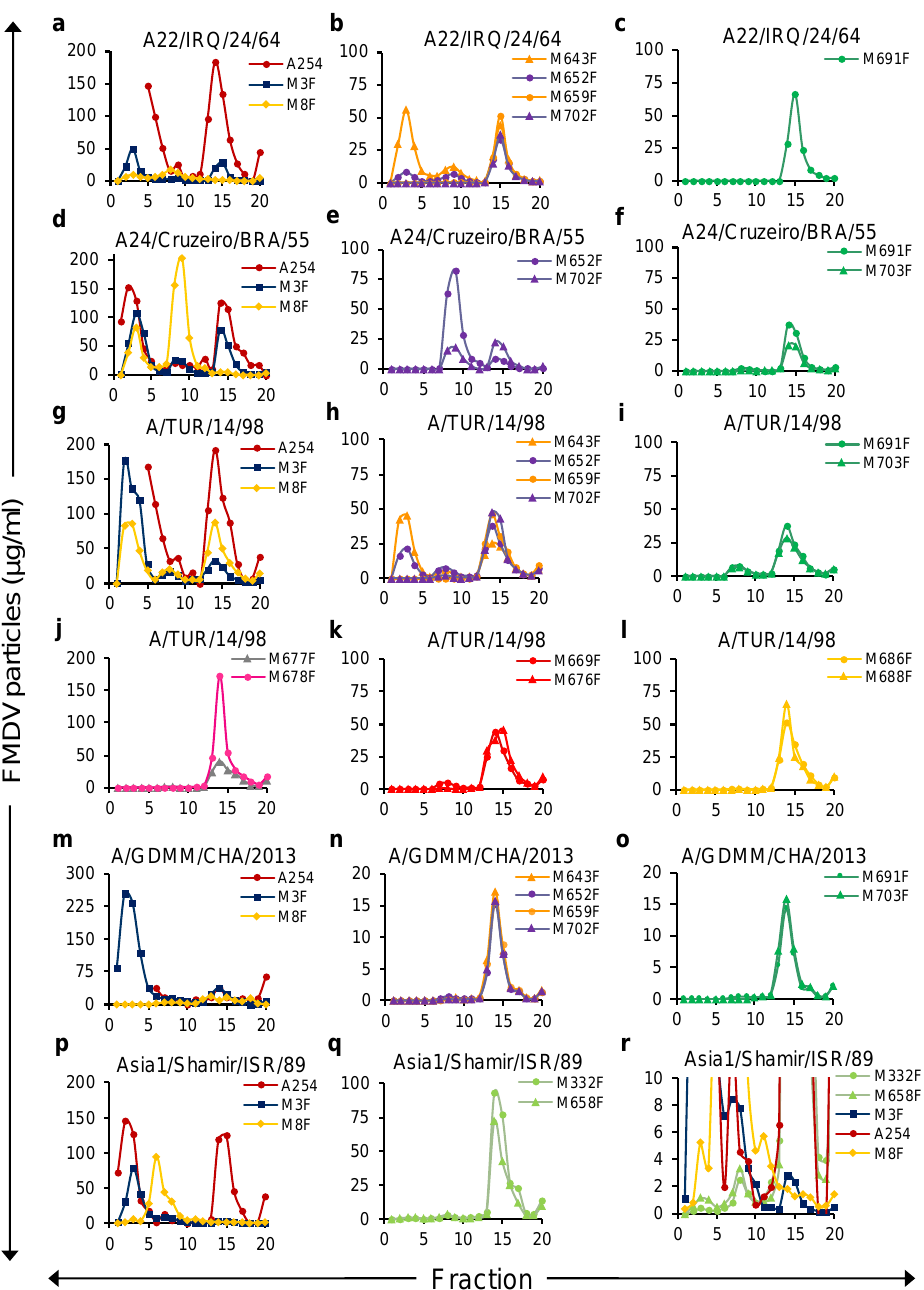
Figure 4. Specificity of novel VHHs for FMDV particles fractionated by SDG. SDG fractions were analyzed using various VHH based DAS-ELISAs. FMDV strains A22/IRQ/24/64 ( a – c ), A24/Cruzeiro/BRA/55 ( d – f ), A/TUR/14/98 ( g – l ), A/GDMM/CHA/2013 ( m – o ) and Asia1/Shamir/ISR/89 ( p – r ) were used. SDG were layered with a 1:1 mixture of FMDV particle preparations that were either untreated or heated for 1 h at 56 °C to ensure the presence of both 146S and 12S. The 20 fractions were analyzed by the measurement of absorbance at 254 nm to identify the 146S peak and by two ELISAs using the broadly reactive VHHs M3F and M8F to identify all peaks ( a , d , g , m , p ). The other panels contain the putative 146S-specific VHHs, with each panel containing clones from a single CDR3 group, except panel ( j ), which contains two VHHs from different CDR3 groups. Clones from the same CDR3 group have identical line colors except for the four VHHs of the same CDR3 group in panels ( b , h , n) that were given two colors to allow discrimination of curves. Panel ( r ) represents the same data as panels ( p , q ) with a different Y -axis scale to enable visualization of lower peaks. Only for the M3F ELISAs, SDG fraction samples and standards were heated for 1 h at 56 ◦ C prior to ELISA. The 12S peak appeared in fractions 1–5, while that of 75S appeared in fractions 7–10 and 146S in fractions